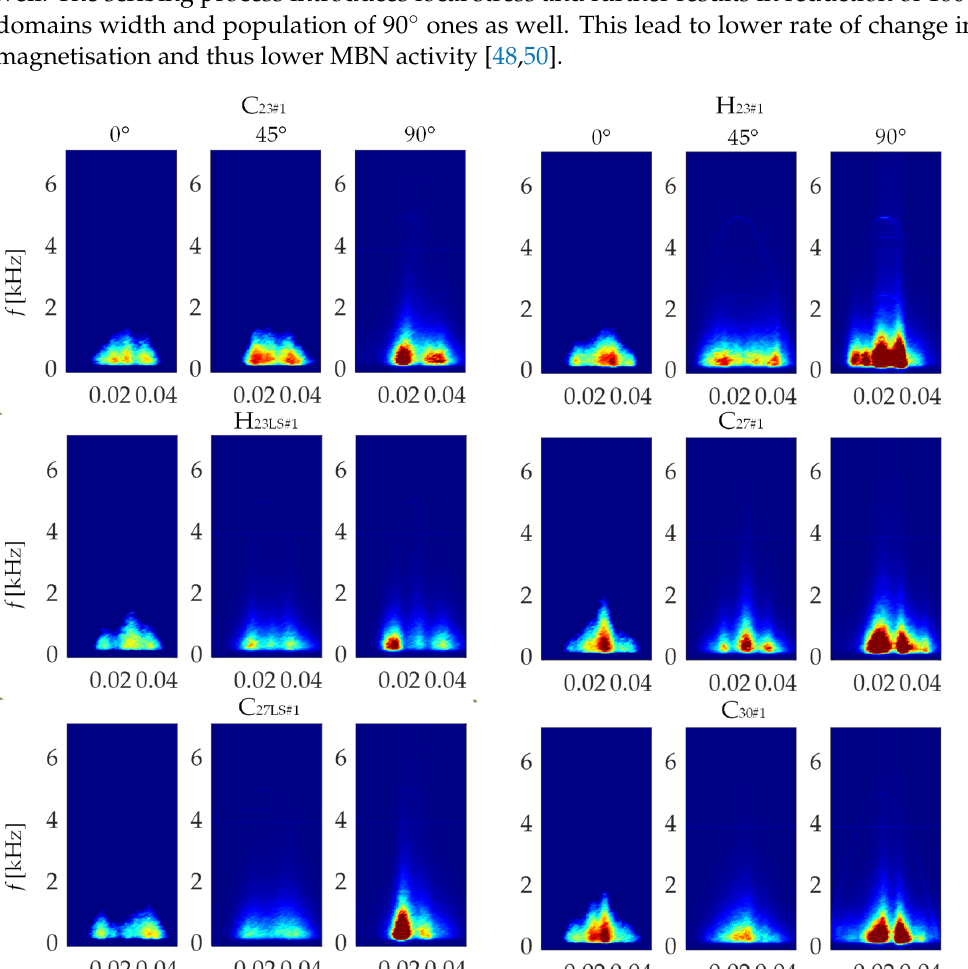
Figure 7. Selected amplitude of STFT spectrograms |S BN ( t, f )| 2 obtained for three different angles between magnetization direction and the TD direction.